Question: What type of chart is this?
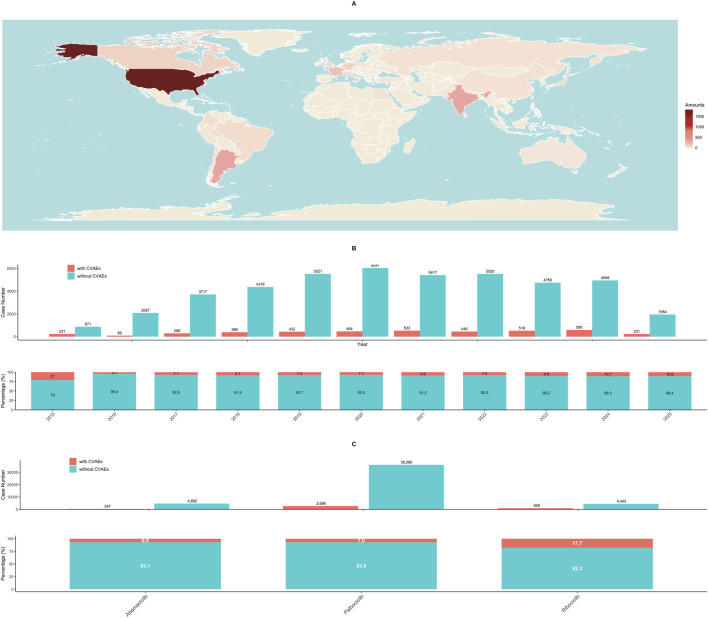
Answer: bar